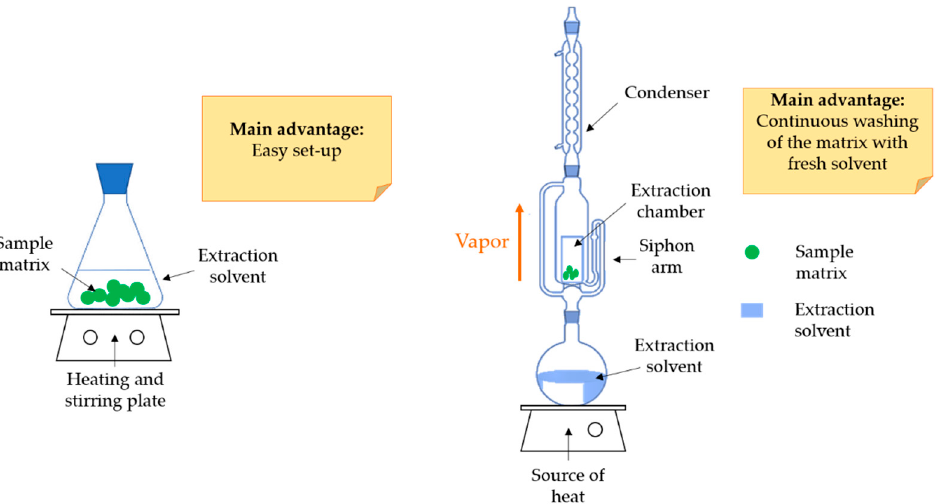
Figure 2. Schematic representation of the main CSE used: maceration extraction (ME) with a source of heat ( left ) and Soxhlet extraction ( right ).